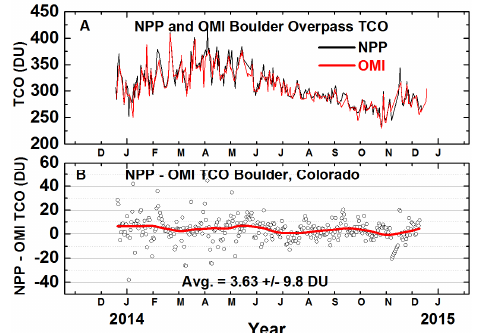
Figure 8. (a) Comparison of retrieved Boulder, Colorado, overpass TCO; (b) difference NPP – OMI TCO.